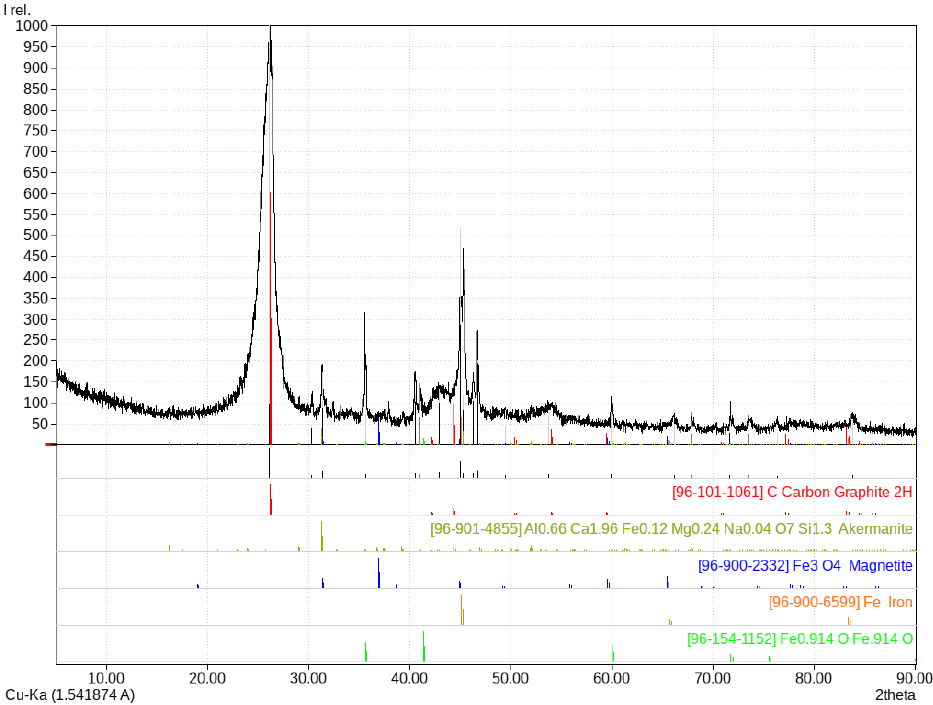
Figure 7. X-ray diffraction (XRD) pattern of CC02 briquette after TGA-MS test.